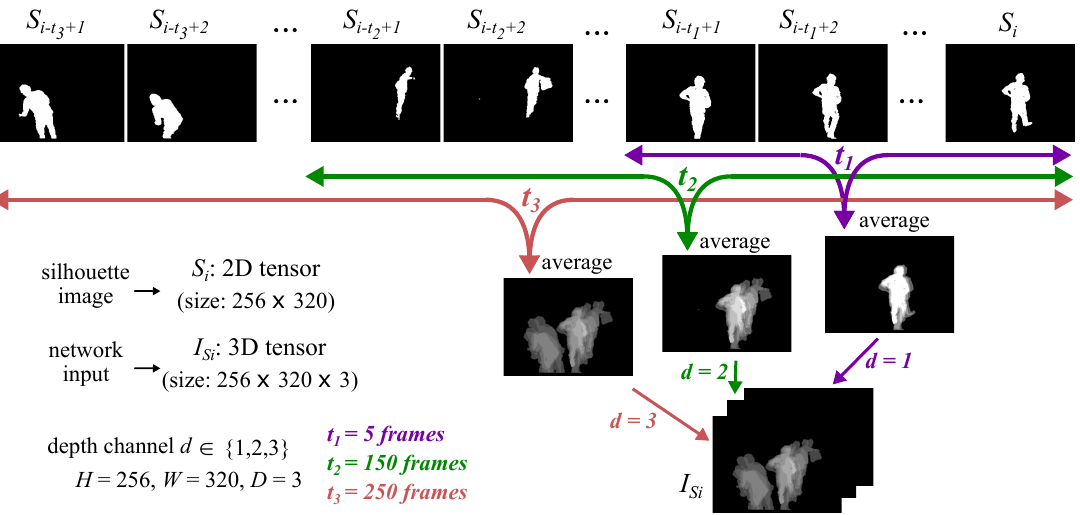
Figure 3. Illustration of the temporal encoding for the silhouette images according to Equation (1). The three depth channels consist of averaged images over 5, 150, and 250 frames, of the network silhouette input I S i